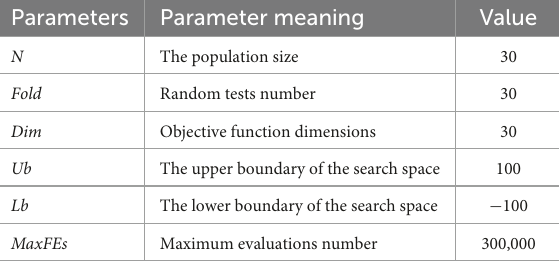
TABLE 3 The parameter setting of the experiment.